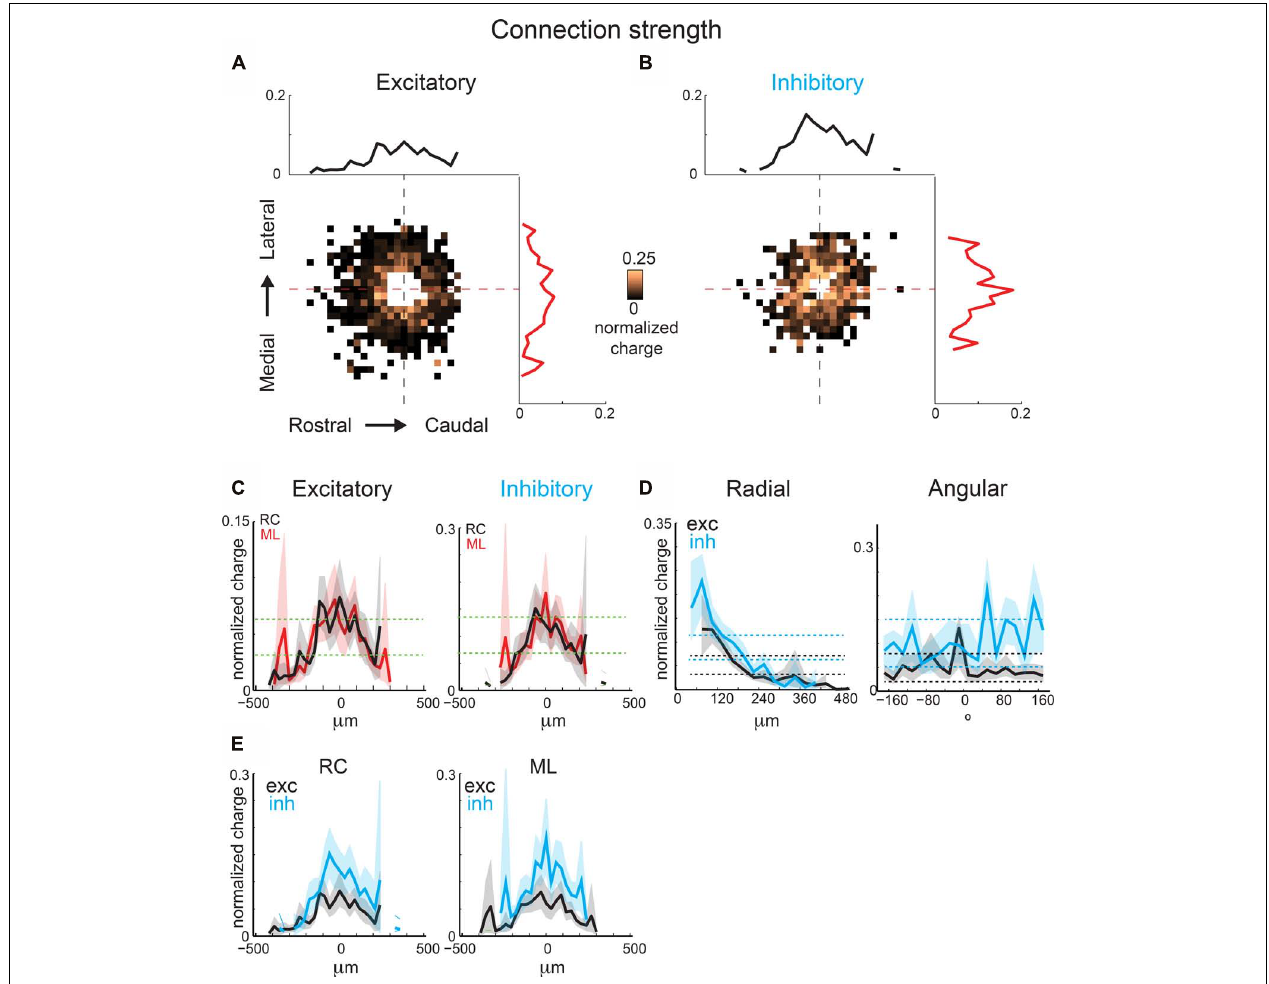
FIGURE 7 | Mean strength maps from the same population of neurons as in Figure 4 are consistent with connection probability trends. Excitatory (A) and inhibitory (B) mean strength maps show increased patchiness relative to mean connection probabilities. (C) Overlaid ML and RC marginal profiles from (A,B) for excitatory (left) and inhibitory (right) inputs. Green dashed lines indicate the 95% confidence interval for the mean of the shuffled image. The shaded